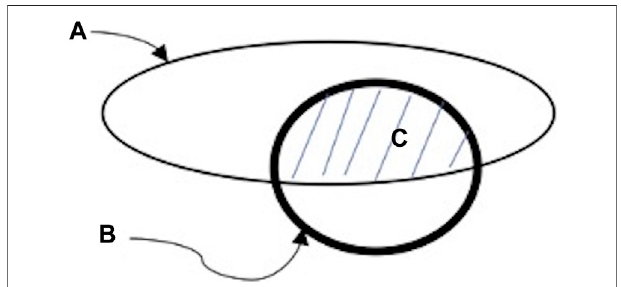
FIGURE9| AreaAisproportionaltothenumberofagentsdependentby Ag i per τ k ; Area B is proportional to the number of agents on which Ag i depends per τ s ; Area C is the intersection of